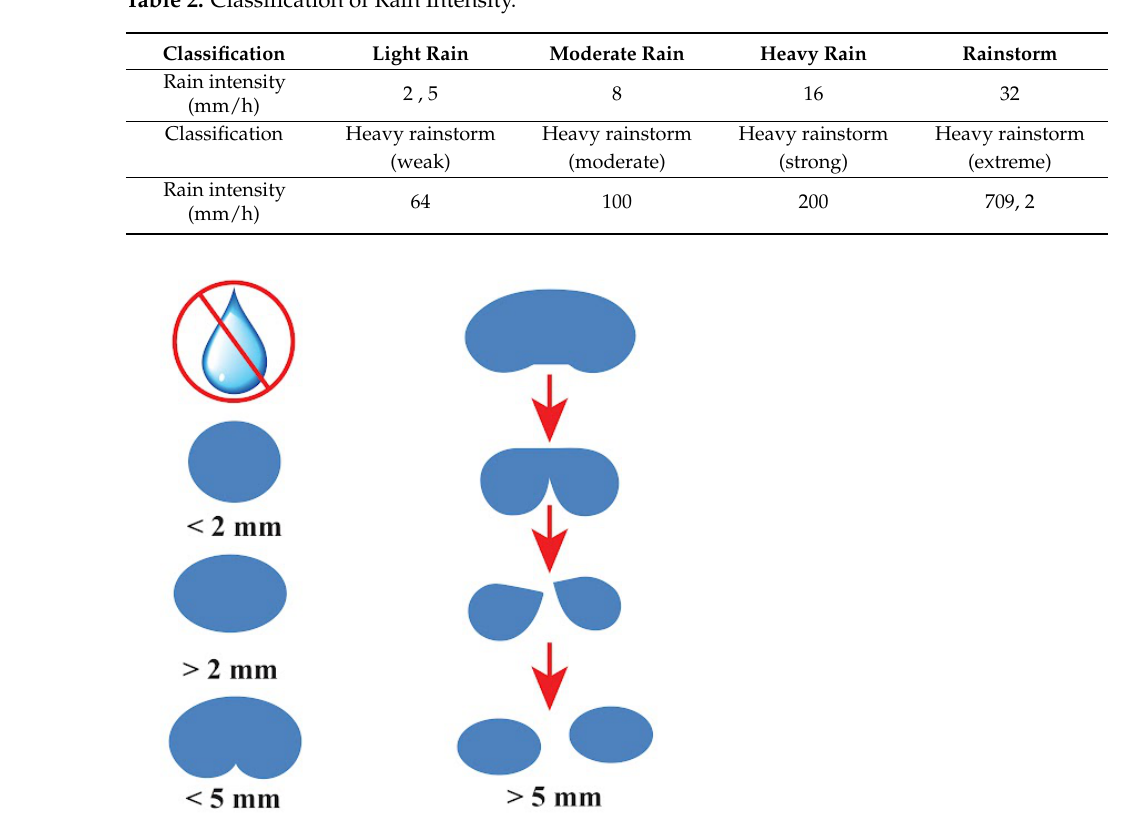
Figure 8. Morphological changes of a falling